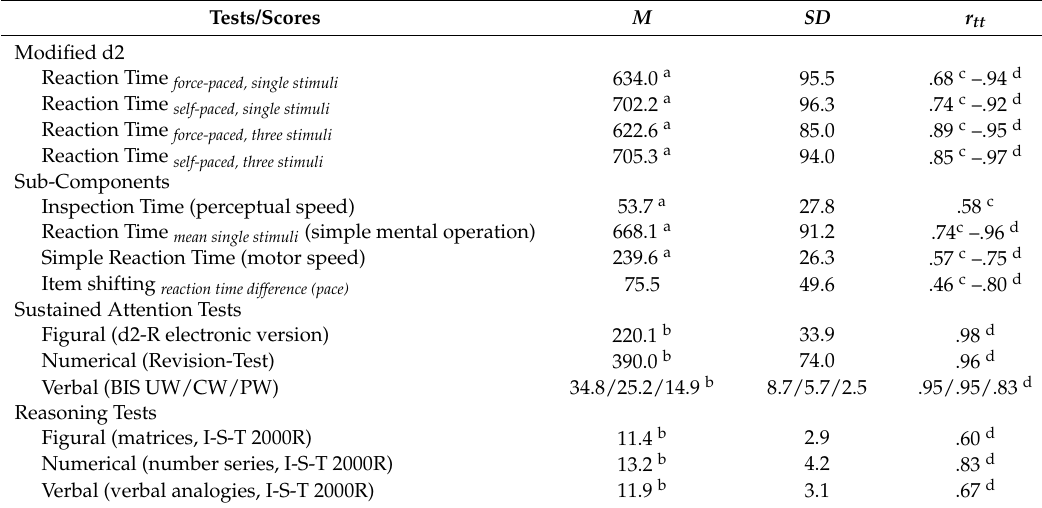
Table 2. Means, standard deviations, and reliability estimates of the measures in Study